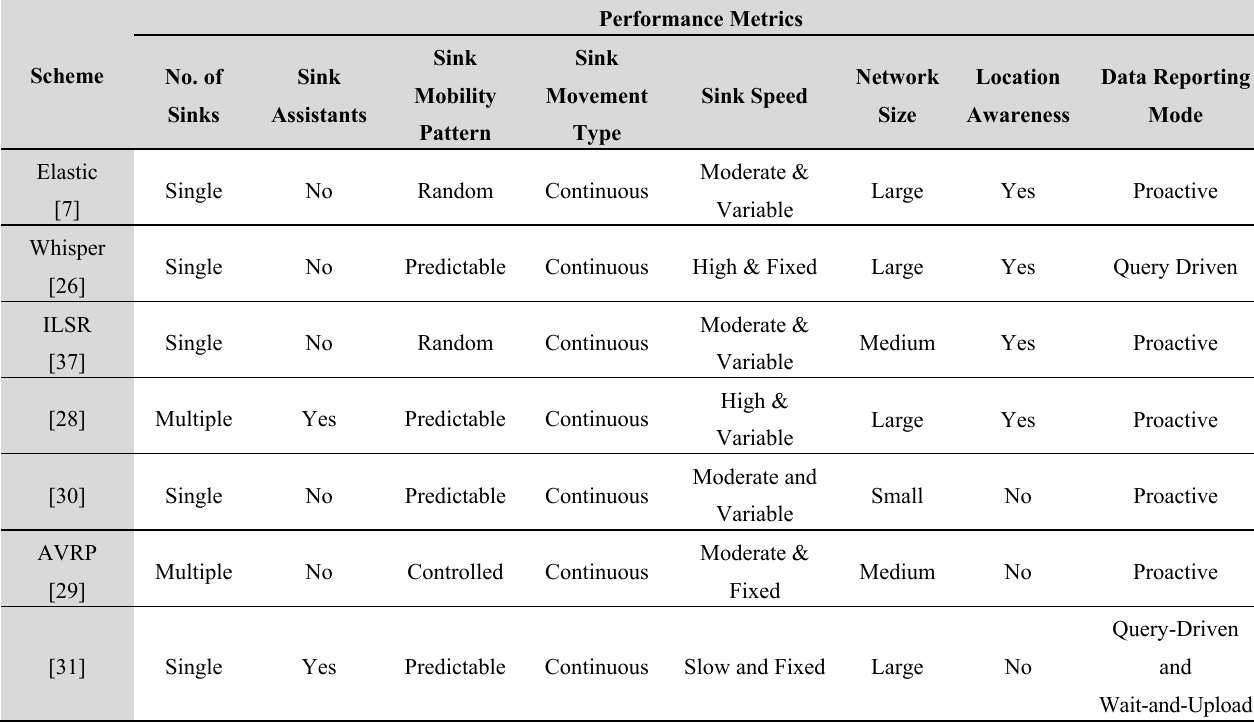
Table 6. Comparative study of data collection/dissemination schemes aiming at successful data delivery performance.